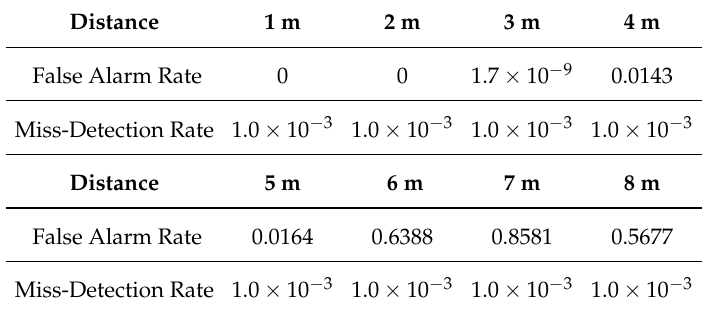
Table 6. Performance analysis in a heavy clutter environment when P Fa = 10 − 4 , P Md = 10 − 3 , α = 0.